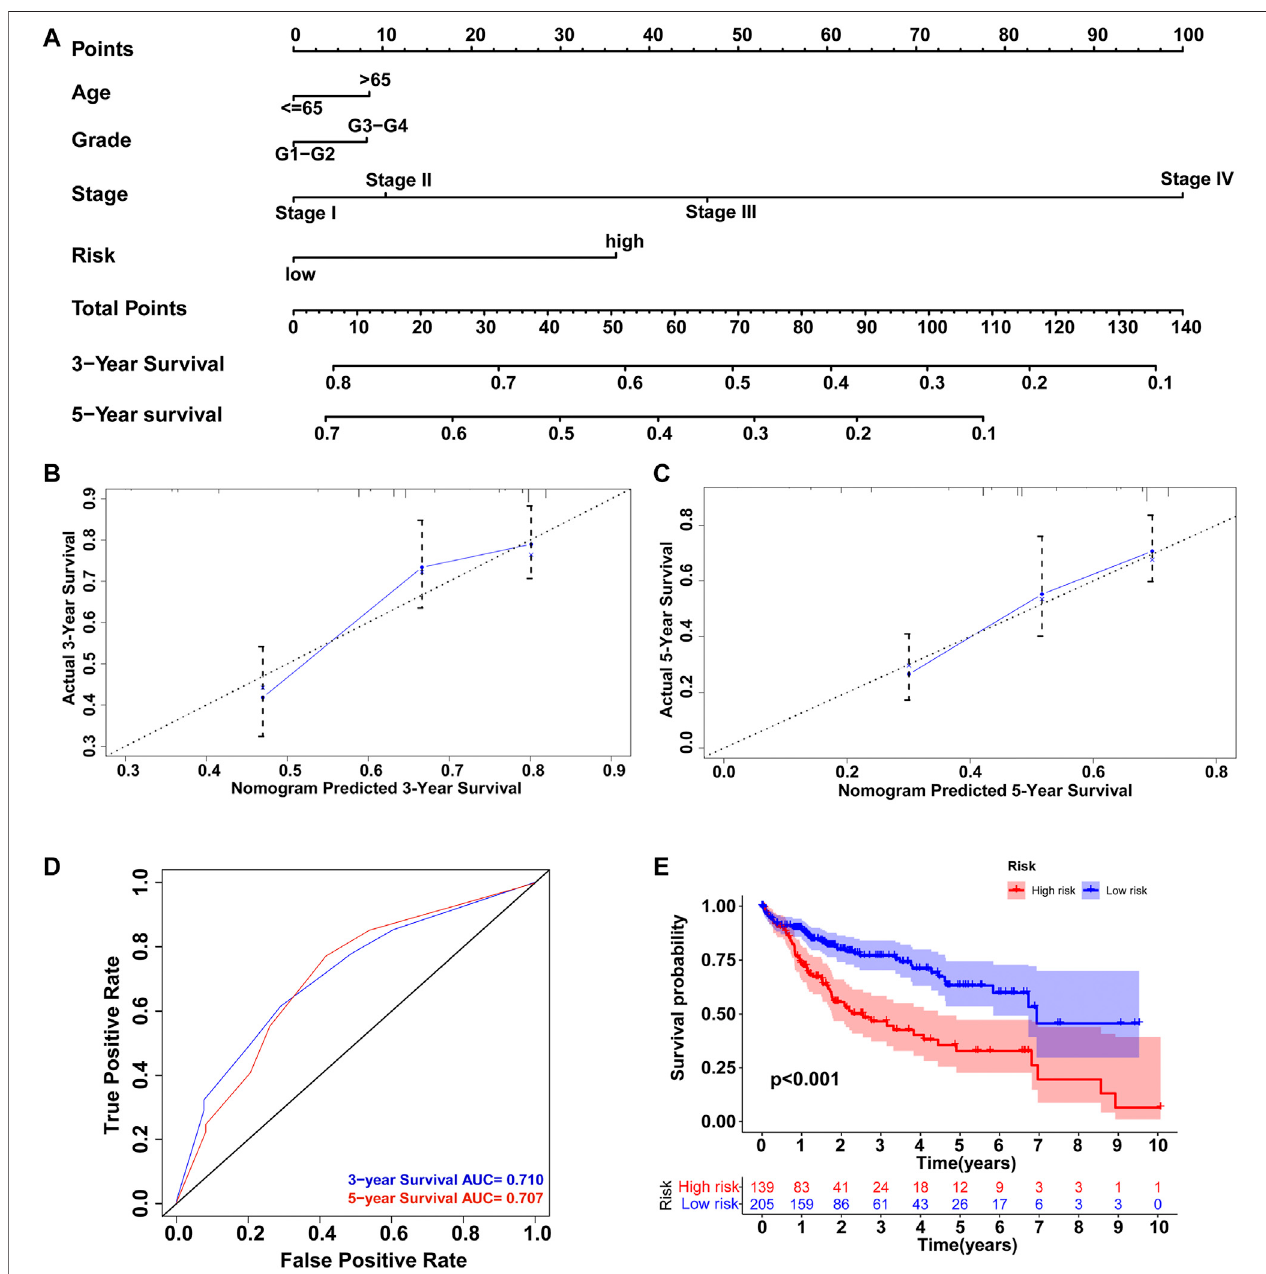
FIGURE10| ConstructionofnomogramtopredicttheprognosisofHCCpatients. (A) ComprehensivenomogramintegratingtheGILncSigandclinicopathological features. Calibration plot of the nomogram model to predict (B) 3-years survival and (C) 5-years survival. (D) ROC curves of the model prediction of 3 and 5-years survival. (E) Kaplan – Meier survival analysis of the high-risk and low-risk groups classi fi ed by the